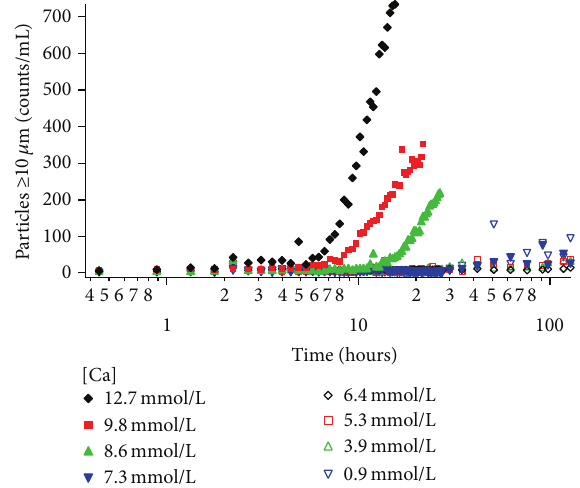
Figure 4: The effects of calcium concentration ranging from 0.9 mmol/Lto12.7 mmol/Loncalciumphosphateparticleformation for a nutritional admixture stored at 37 ∘ C are monitored through the appearance of particles ≥ 10 microns in size. The time-dependent evolution of particle counts/mL shows shorter induction times and greater particle concentrations with increasing calcium concentra- tions greater than 7.3